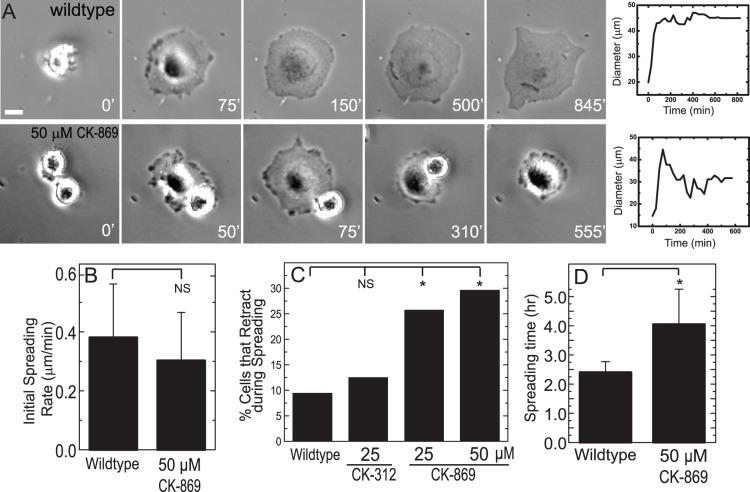
Arp2/3 inhibited cells show defects in spreading.(A) Time series of untreated (wild type) cells or cells treated with 50 µM of CK-869; time indicated in minutes. Panels to the right show representative graph of spread area versus time for a cell in the cells presented in A. Scale bar = 10 µm (B) Rates of cell spreading in wildtype MCF10A cells or cells treated with 50 µM CK-869. Rates of spreading were calculated from the slopes of kymographs of the cell edge (n = 22 cells for wild type and 21 cells for CK-869). (C) Fraction of cells that retracted after reaching their maximum spread area. The ratio of the full spread area (FSA) to the smallest spread area (SSA) was calculated and if FSA/SSA >2, the cell was included as a retraction (n = 53 untreated cells, n = 64 for 50 µM control compound (CK-312) and n = 35 and 27 cells for 25 and 50 µM CK-869, respectively). (D) Bar graph of the time in hours to reach maximum spread area for untreated MCF10A cells or cells treated with 50 µM CK-869. NS, not significant; *, P<0.05 with respect to WT or control.